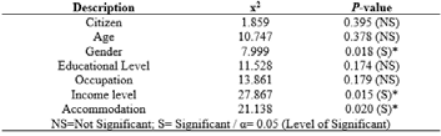
Table 10: Demographic Background versus Solid Waste Dumping Adjacent to Respondents’